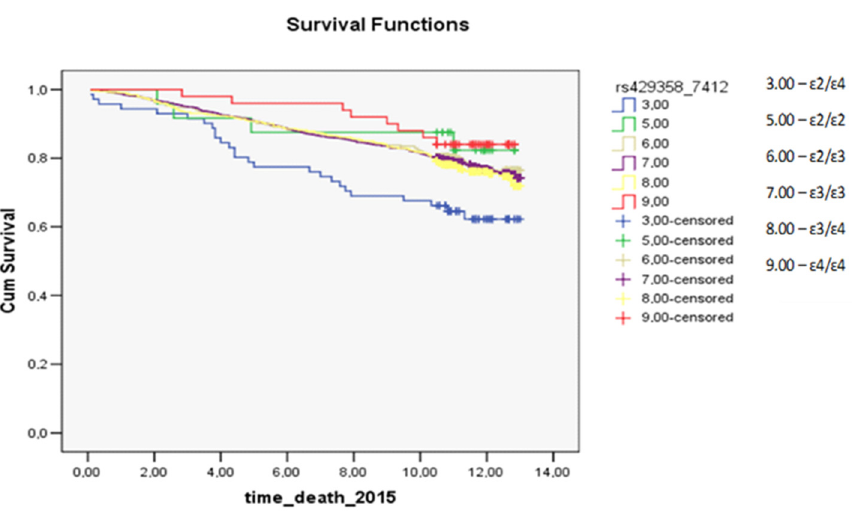
Figure 1. The survival plot for myocardial infarction in the female subgroup: the prognosis was worse for carriers of the ɛ 2/ ɛ 2 genotype (green curve) and for ɛ 4/ ɛ 4 carriers (red curve) ( p = 0.0006). time_death_2015: this is the time (in years) from the start of the observation (December 2002) to the end of the study (the occurrence of the outcome or the end of the observation period: December 2015). Cum Survival: the probability that the case has no outcome until the time point that we choose along the horizontal axis.